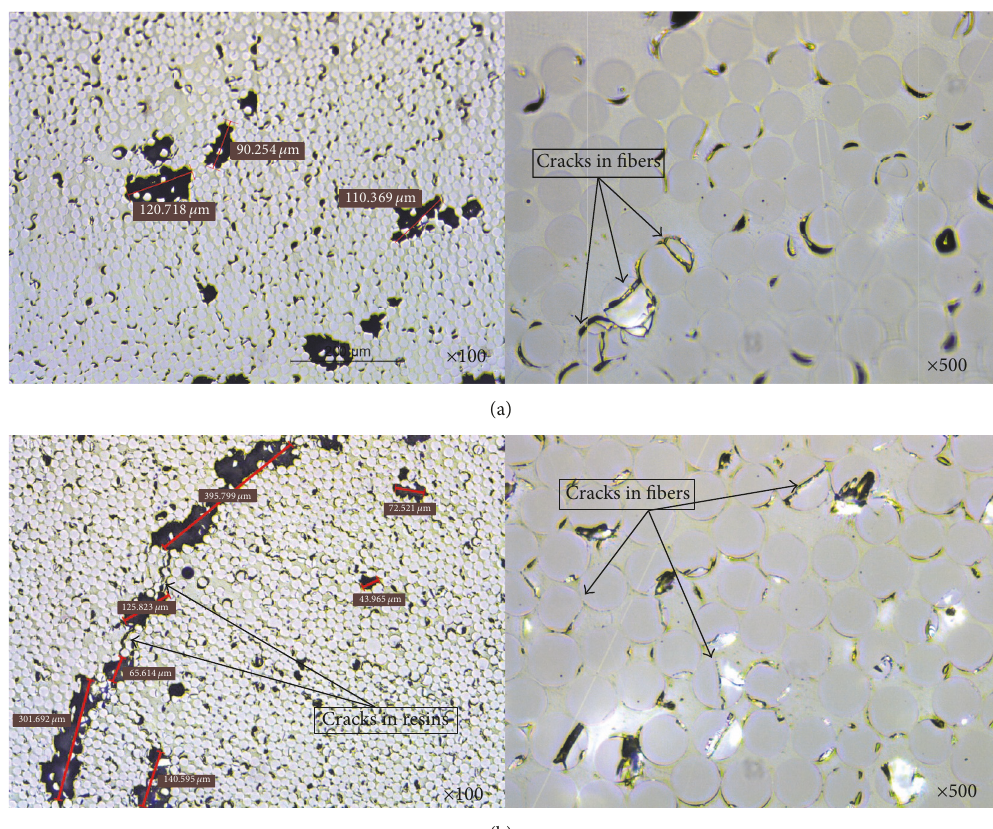
Figure 16: Optical microscopic images before immersing into alkaline solution: (a) PH 120 and (b) PH 200